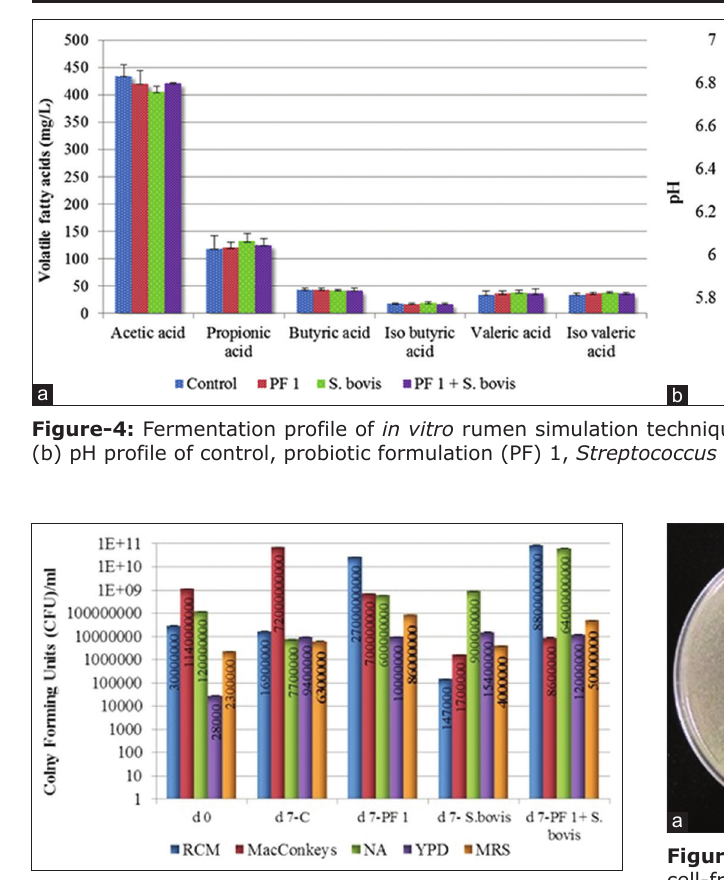
Figure-5: Day 0 versus day 7 total viable count estimation of strict anaerobic bacteria, coliforms, aerobic bacteria, yeast and facultative anaerobic bacteria for probiotic formulation (PF) 1, Streptococcus bovis and PF 1+ S. bovis interventions in comparison with control.